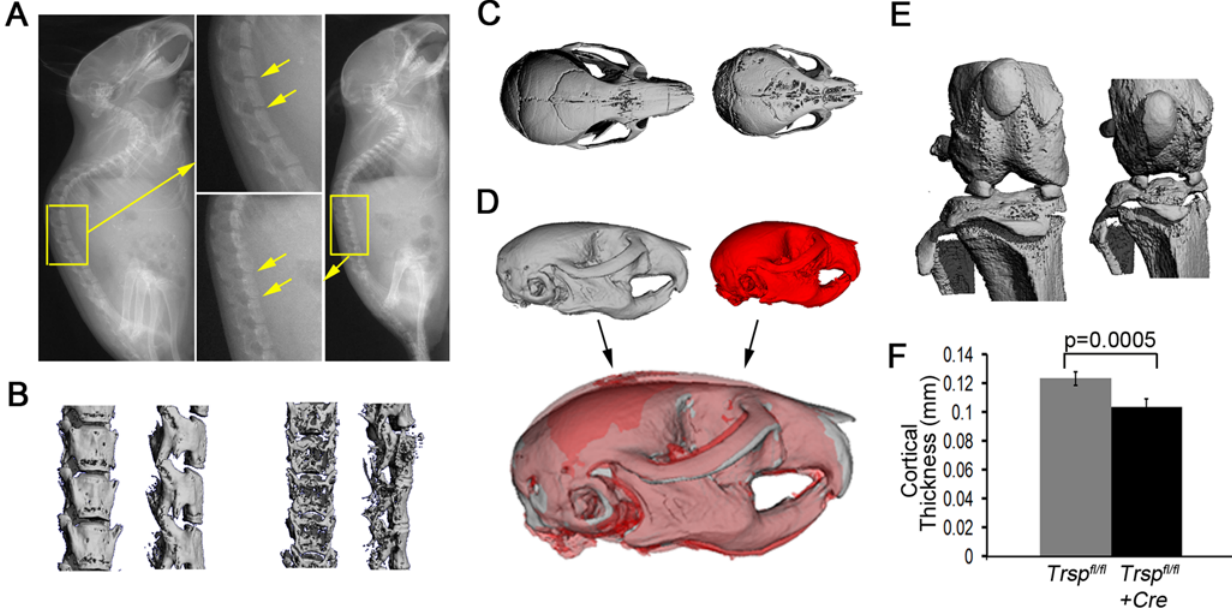
Figure 2. Compromised skeletal development in Trsp fl/fl Col2a1-Cre mice. (A) Radiographs of representative Trsp fl/fl (left) and Trsp fl/fl Col2a1-Cre (right) mice. Arrows within the magnified areas highlight the irregularly-shaped vertebral bodies and narrowed intervertebral disc spaces in the Trsp fl/fl Col2a1-Cre spinal column. (B) Ventral and lateral micro-CT views of lumbar vertebrae from Trsp fl/fl control (left) and Trsp fl/fl Col2a1-Cre (right) mice showing delayed spinal column ossification and loss of intervertebral disc spaces. (C) Micro-CT scans of the dorsal aspect of control (left) and experimental (right) skulls show smaller overall head size, rounding of the cranium (with possible decreased frontal bone ossification), and nasal bone shortening in the Trsp fl/fl Col2a1-Cre mouse. (D) Generalized shape images of representative skulls. Ten mutant mice were used to generate this phenotypic average for the Trsp fl/fl Col2a1-Cre mice (red skull) and nine Trsp fl/fl controls were used (grey skull); the overlay of the images is presented beneath. Note that skull sizes from the control and experimental groups have been normalized, thus, only differences in shape of the cranium are being revealed by the overlay technique. (E) Anterior micro-CT views of knee joints from control (left) and experimental (right) mice showing smaller overall size in the latter, yet with relatively wide growth plates being present in the Trsp fl/fl Col2a1-Cre tibia and fibula. (F) Cortical bone thickness difference (p=0.0005) between the genotypes at the mid-shaft of the femur measured by micro-CT (n=5). Data are mean + / 2 SEM, and were from 3.5–4 wk old mice.